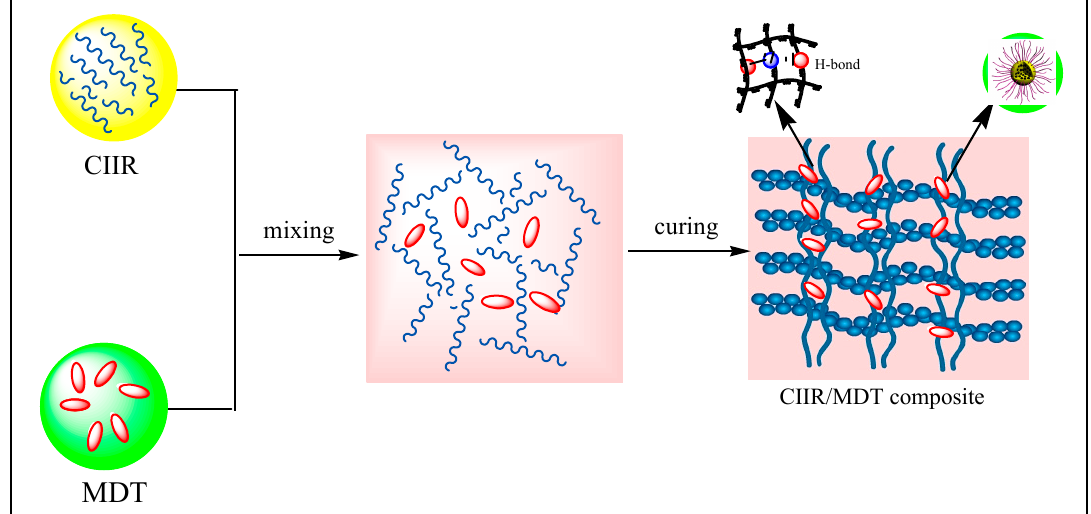
Figure 9. Fabrication process of CIIR damping composites based on MDT.